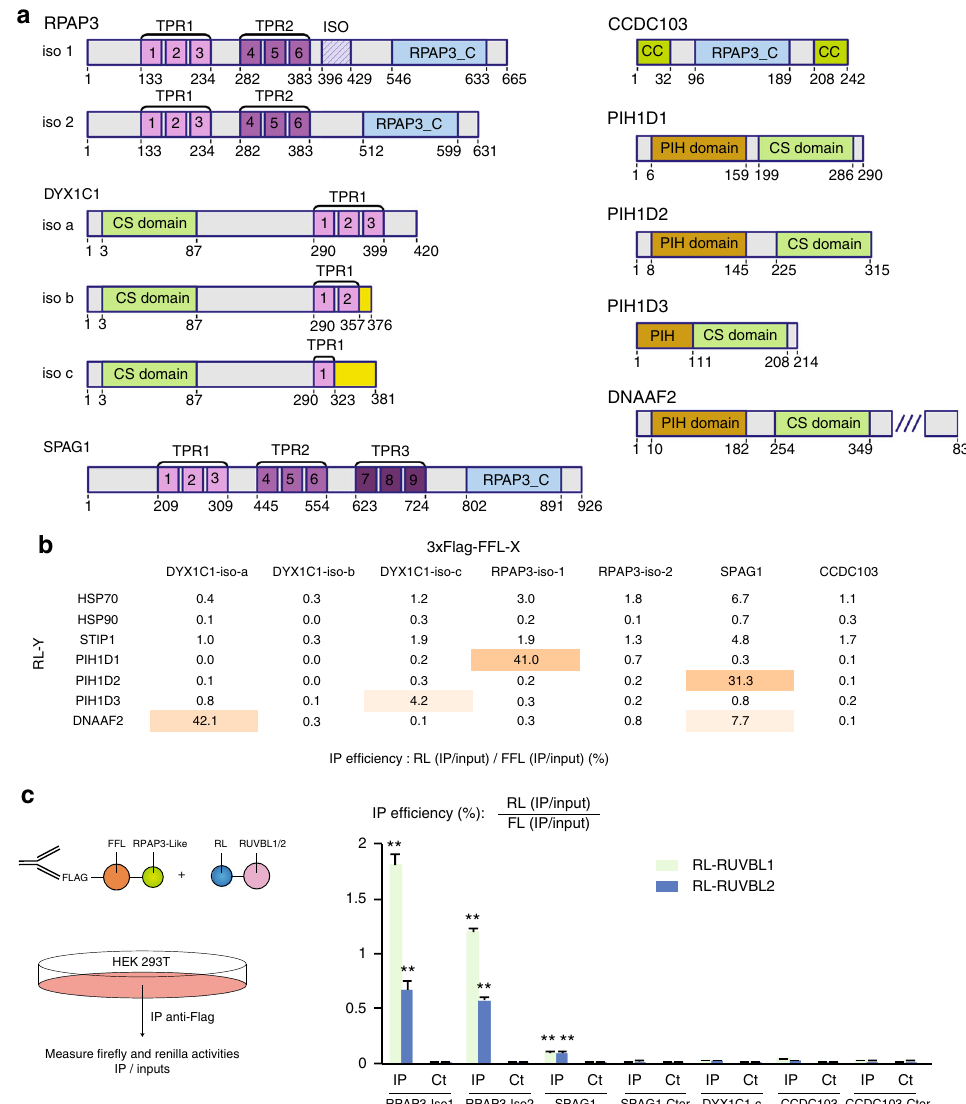
Fig. 4 RPAP3-like and PIH1-like proteins interact with each other. a Architecture of the human proteins containing a RPAP3-Cterminal domain (RPAP3-C), or a PIH domain (PIH). Coiled-coil (CC), CHORD-containing proteins and SGT1 domain (CS) and TPR domains (TPR) are also indicated. Different splicing isoforms of RPAP3 and DYX1C1 are shown, with their variable domains in hatched violet (RPAP3), or yellow (DYX1C1). b Summary of pairwise LUMIER interaction assays between the indicated proteins. The values are the ef fi ciencies of the co-precipitation of the RL fusion proteins (IP/Input), expressed in percent of the ef fi ciencies obtained with the 3xFLAG-FFL fusions. p -values are shown in Supplementary Fig. 4C. c LUMIER interaction assays between RL- RUVBL1/2 and RPAP3-like proteins tagged with 3xFLAG-FL. Legend as in Fig. 3c. Stars: values signi fi cantly greater than six-times the mean value obtained in the control IP (Ct). ** p -value < 0.001 ( Z